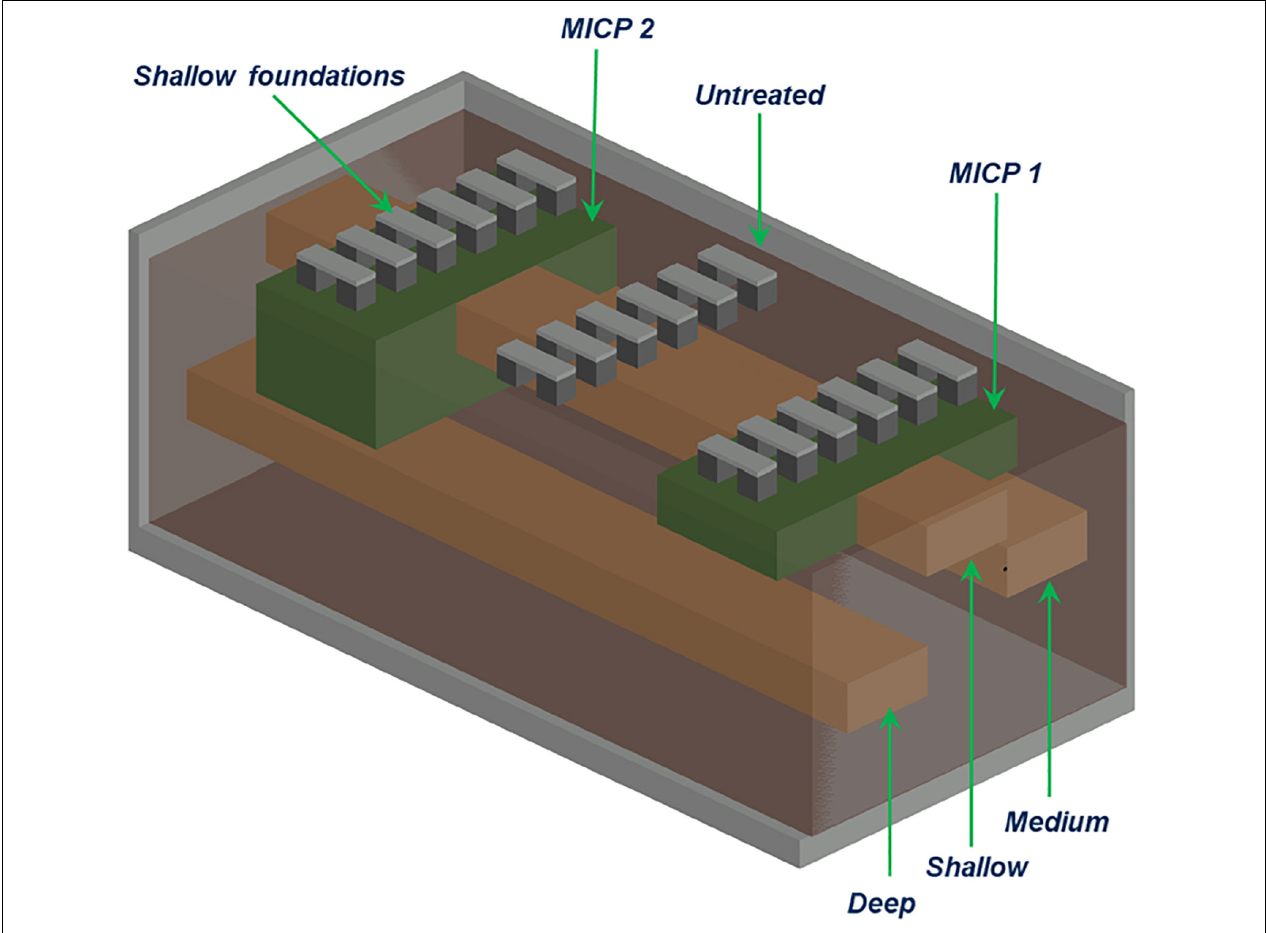
FIGURE 14 | Configuration of a centrifuge model for the 9-m centrifuge; multiple shallow foundations arranged over areas that have no, shallow, and deep MICP treatments (labeled as Untreated, MICP 1 and MICP 2) with loose layers of liquefiable sand at shallow, medium, and deep